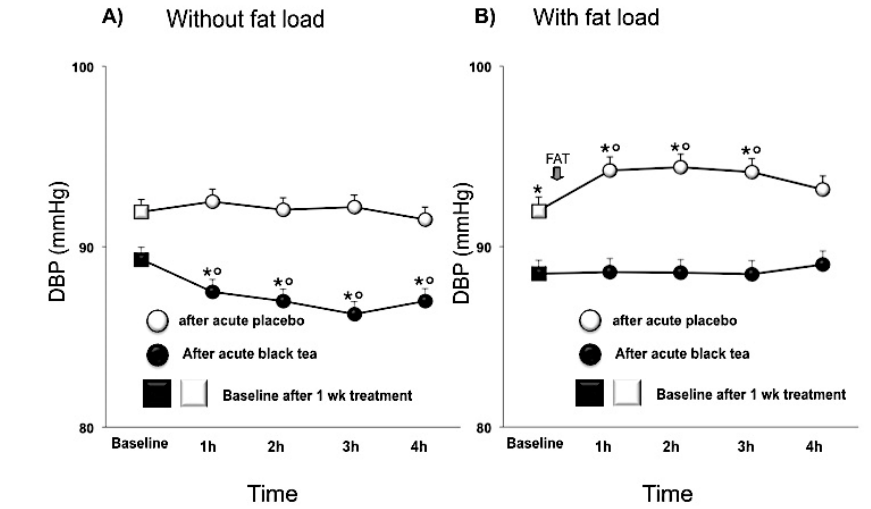
Figure 4. Effect of 1 week placebo (white) and black tea (black) administration on baseline (square) values (Panel A and B ) of diastolic blood pressure and acute effects without and with fat load (Panel A and B ). Data are presented as LSmeans ± SE. In all panels vertical lines indicate SE and asterisks (*) indicate significant differences with respect the placebo phase (Panel A and B ) while circles (°) indicate significant differences from baseline values (Panel A and B ). Differences are considered significant when p < 0.05. Table 4. Effect of black tea on haemodynamic parameters after 8 days’ intervention measured in the postprandial state. parameter placebo black tea difference (95% CI) Adj P -value